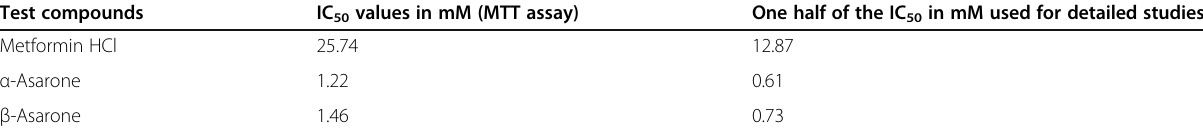
Table 1 The IC 50 values of metformin HCl and α - and β -asarone based on the MTT assay and dose selected for further studies Test compounds One half of the IC 50 in mM used for detailed studies